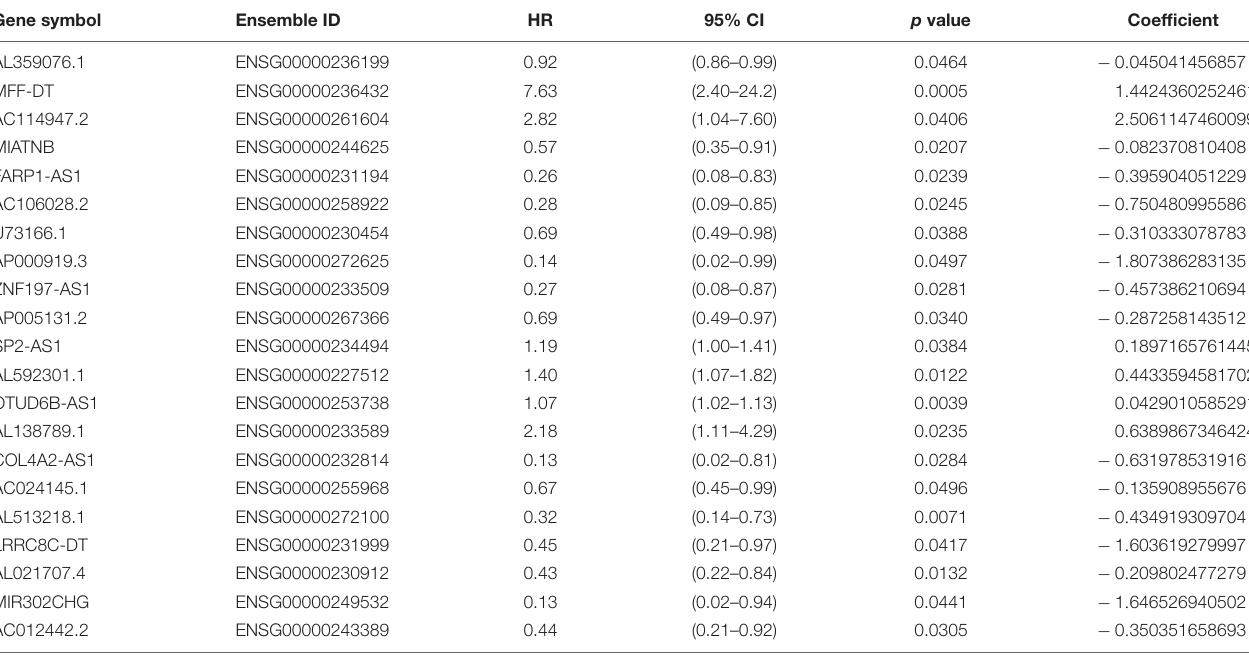
TABLE 1 | The detailed information of the 21 m6A-related lncRNAs used to construct the prognostic